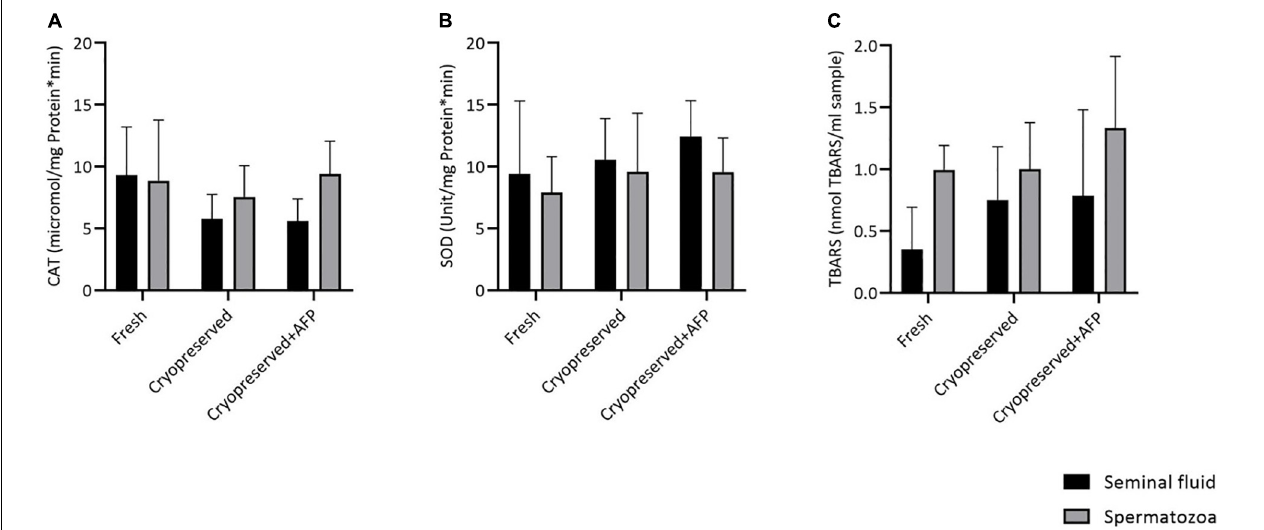
FIGURE 3 | Effect of cryopreservation on lipid peroxidation and antioxidant enzyme activities in fresh, cryopreserved, and cryopreserved sperm with supplementation of 10 µ g/mL AFPI (cryopreserved + AFP) in sterlet spermatozoa and seminal fluid (mean ± SD): (A) catalase activity (CAT); (B) superoxide dismutase activity (SOD); (C) thiobarbituric acid-reactive substances (TBARS) [ p < 0.05, one-way analysis of variance (ANOVA) followed by Tukey’s honest significant difference test].